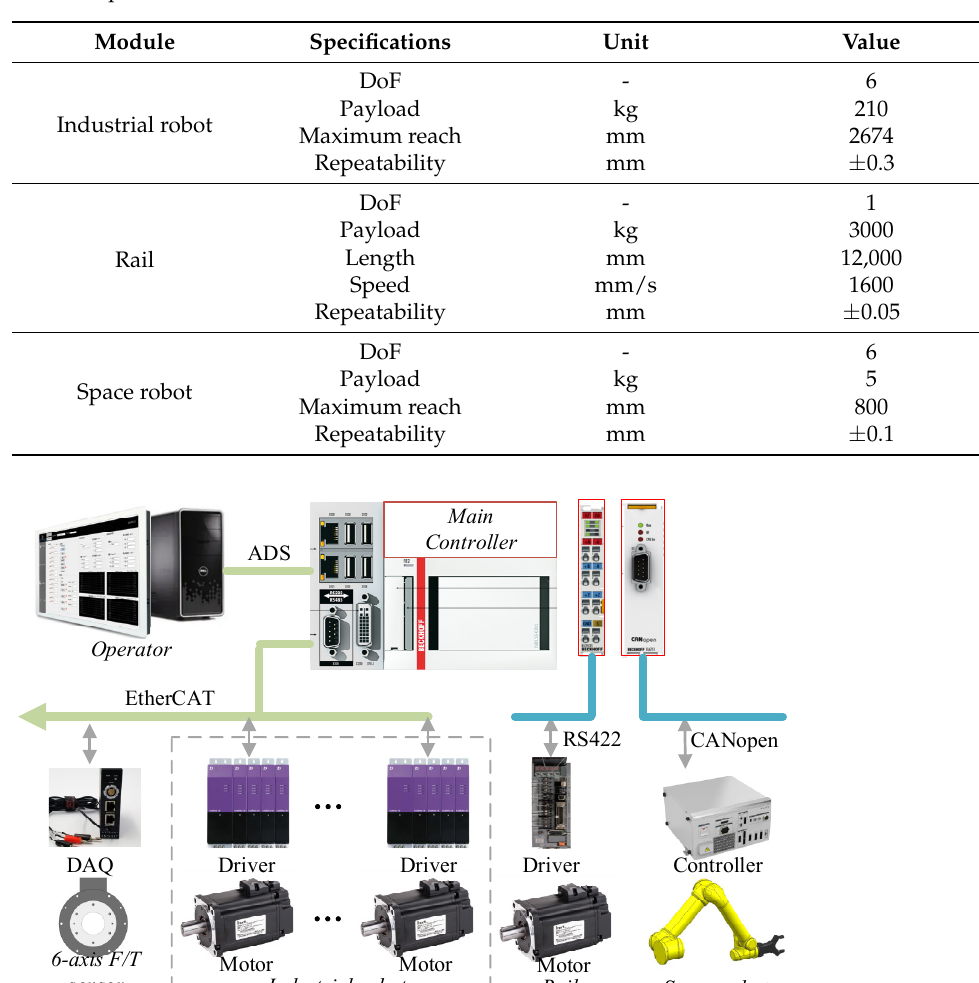
Table 1. Specifications of the HIL simulator.